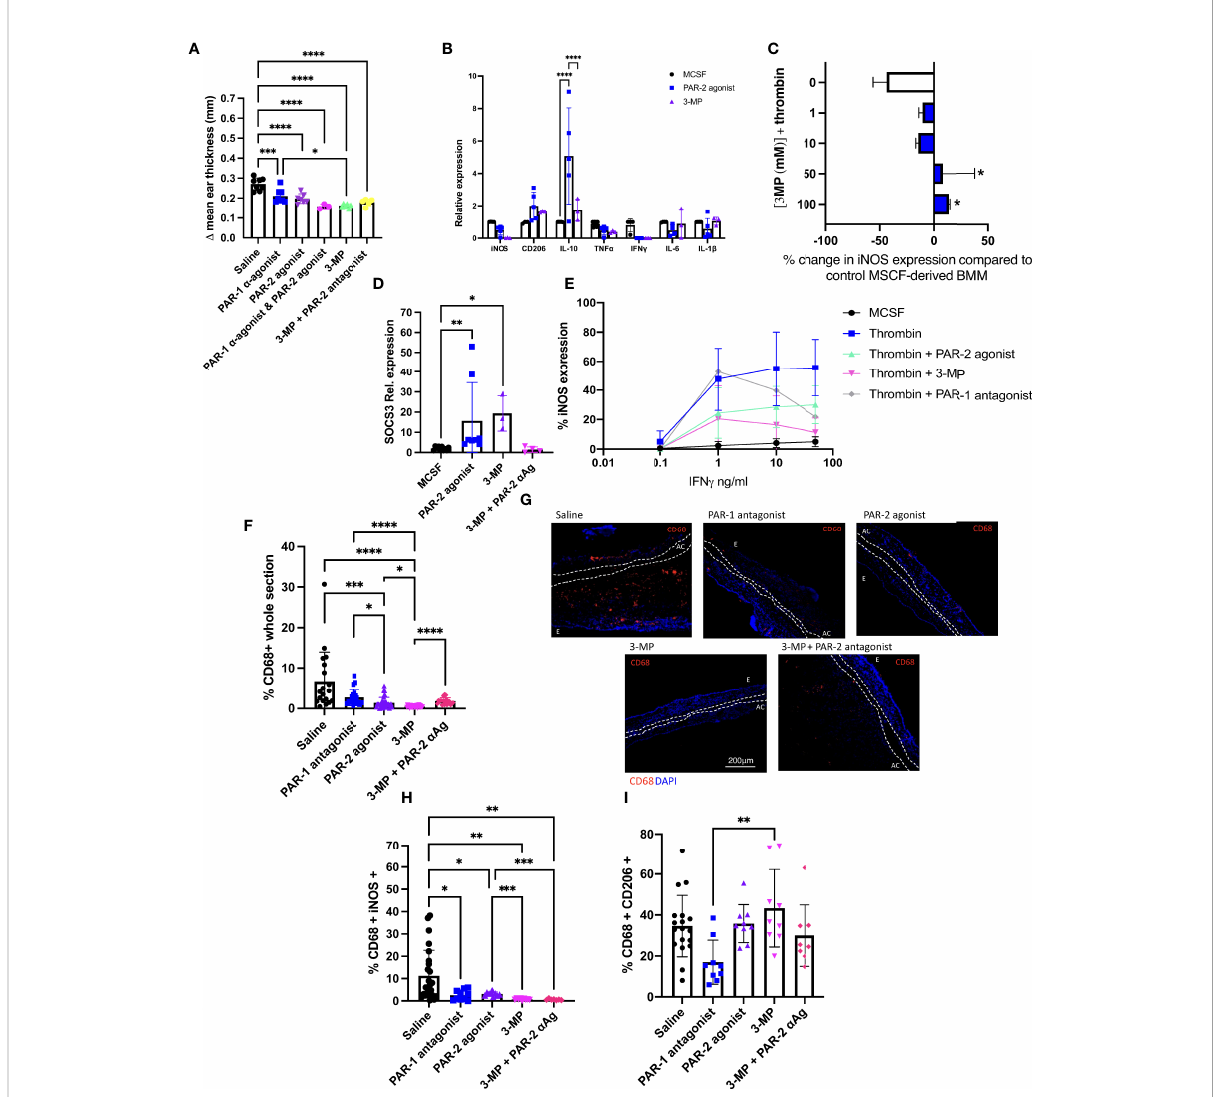
FIGURE 5 3-MP inhibits IFN g signalling through both PAR-1 antagonism and PAR-2 agonism. (A) The impact of combination PAR-1 antagonism and PAR-2 agonism on the outcome of Ox-DTH. Immediately prior to re-challenge with oxazolone, C57BL/6 (WT) mice received either IP saline (n= 8) or 10microM/g IP FLLRN (PAR-1 antagonist ( a -agonist) (n=8), 2-Furoyl-LIGRLO-amide (PAR- 2 agonist) (n=7), FLLRN combined with 2-Furoyl- LIGRLO-amide (n=3), 3-MP (n=6) or 3-MP + FSLLRY-Amide (PAR-2 antagonist) (n=5). Data represented as D mean ear thickness. (B) qPCR data for day 5 MCSF-derived BMM incubated for 24 hours with 100 m M PAR-2 agonist or 100 m M 3- MP or maintained in MCSF alone. Expression calculated relative to TBP. Data from 3 separate experiments. (C) Day 5 MCSF-derived BMM were cultured for 2 hours with escalating concentrations of 3-MP prior to thrombin stimulation for 24 hours. Control cells were incubated in thrombin alone (white bar). Cells were then analysed by fl ow cytometry for surface ABCA1 expression. Data from 3 separate experiments. Signi fi cance compared to control conditions (white bar). (D). qPCR for SOCS3 expression by control MCSF-derived BMM maintained in MCSF for 24 hours (black circle) (n=10), or after 24 hours incubation with 100 m M PAR-2 agonist (blue square) (n=8) or 3-MP (purple triangle) (n=3) with or without a 2-hour pre incubation with PAR-2 antagonist ( a Ag) (FSLLRY-NH2) (pink diamond) (n=4). Expression calculated relative to TBP. (E) MCSF-derived BMM incubated with increasing concentrations of IFN g alone (= ‘ MCSF ’ ), or primed with thrombin for 24 hours (Thrombin) or with thrombin and 100 µM 2-Furoyl- LIGRLO-amide (Thrombin +PAR-2 agonist), 3-MP (Thrombin + 3-MP) or FLLRN (Thrombin + PAR-1 antagonist), prior to IFNv stimulation (thrombin and PAR-2 agonist remained in culture). Cells were then analysed by intracellular fl ow cytometry for iNOS expression. Data shows results from 3 experiments. (F – I) Experimental groups and n numbers as described in Figure 5A. Immuno fl uorescence of frozen sections through oxazolone-treated ears. Bars represent means + SD for saline treated mice (white), IP FLLRN (PAR-1 antagonist) (blue), 2-Furoyl- LIGRLO-amide (PAR- 2 agonist) (purple), 3-MP (pink) or 3-MP and FSLLRY-NH2 (3-MP + PAR-2 antagonist- a Ag) (red). (F) % area of the section occupied by CD68 + cells. (G) Representative two colour IF sections through oxazolone-painted ears. Images show staining with CD68 (red) and DAPI (blue). (H – I) : % of CD68 + cells co-expressing iNOS (H) or CD206 (I) . For ES data at least 5 measurements were taken per ear and the results averaged. Dotted lines demarcate the auricular cartilage (AC). E= epidermis. Samples were compared using Kruskal – Wallis one-way anova for multiple comparisons (Fig 5A,C,D,F,H+I) or two way anova (Fig5B) Bar data represents mean +SD. * P< 0.05 **P < 0.01 ***P < 0.001 **** P <